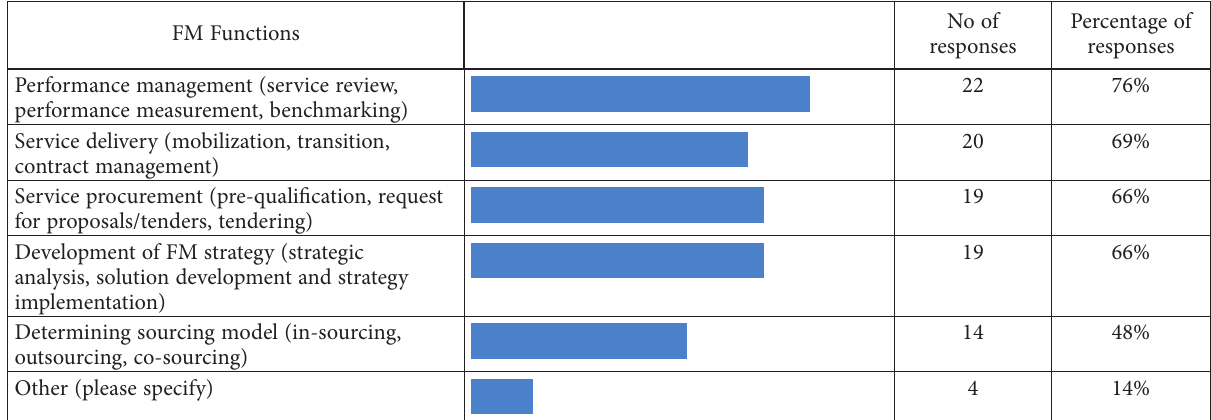
Table 4. Respondents’ roles in